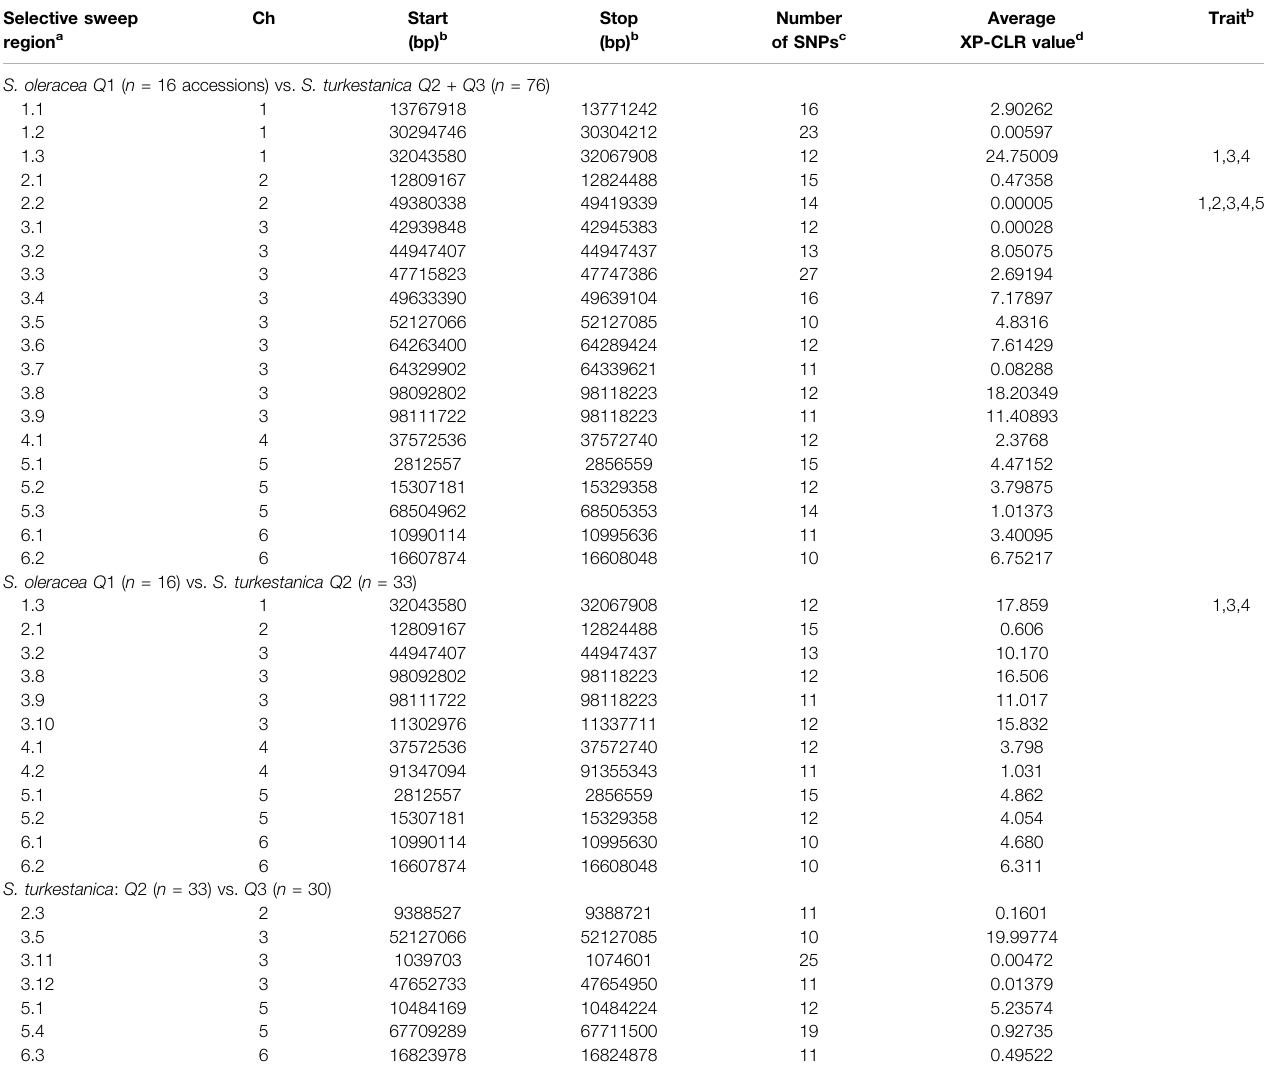
TABLE 4 | Selective sweep regions of 16 Spinacia oleracea ( Q 1) accessions and 76 S. turkestanica ( Q 2 and Q 3) accessions, 16 S. oleracea Q 1 accessions and 33 Q 2 S. turkestanica accessions, and 33 Q 2 and 30 Q 3 accessions within S. turkestanica , as determined by XP-CLR analyses. Selective sweep region a